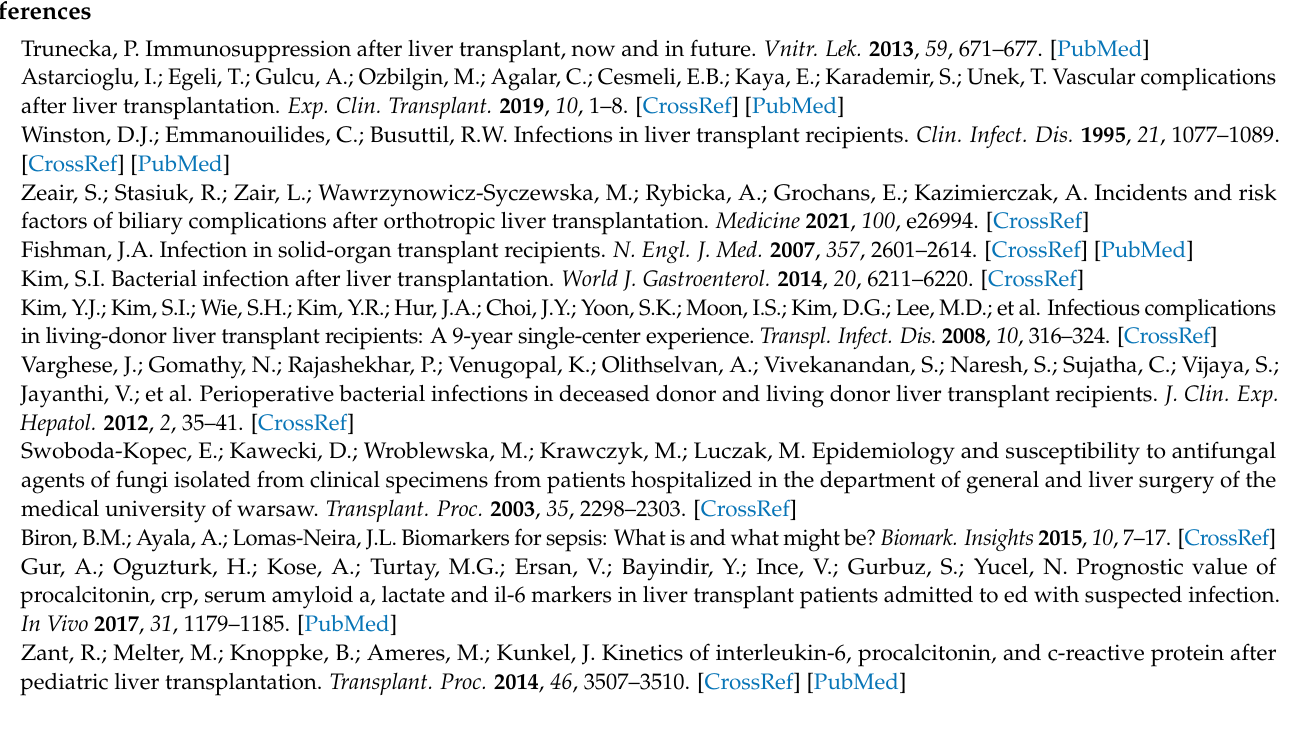
LTX; Supplemental Table S4: Plasma values of transaminases and coagulation parameters; Supplemental Table S5: Plasma values of the infection parameters adjusted to the timepoint of bacterial